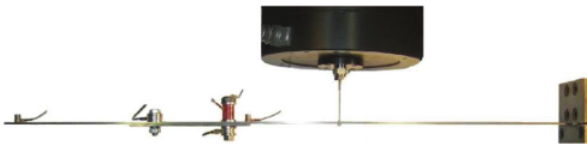
Figure 2: Photograph of the experimental setup with structure, damper beam, piezoelectric stack, force cell, accelerometers, and attached shaker stinger (cf. Figure 1).